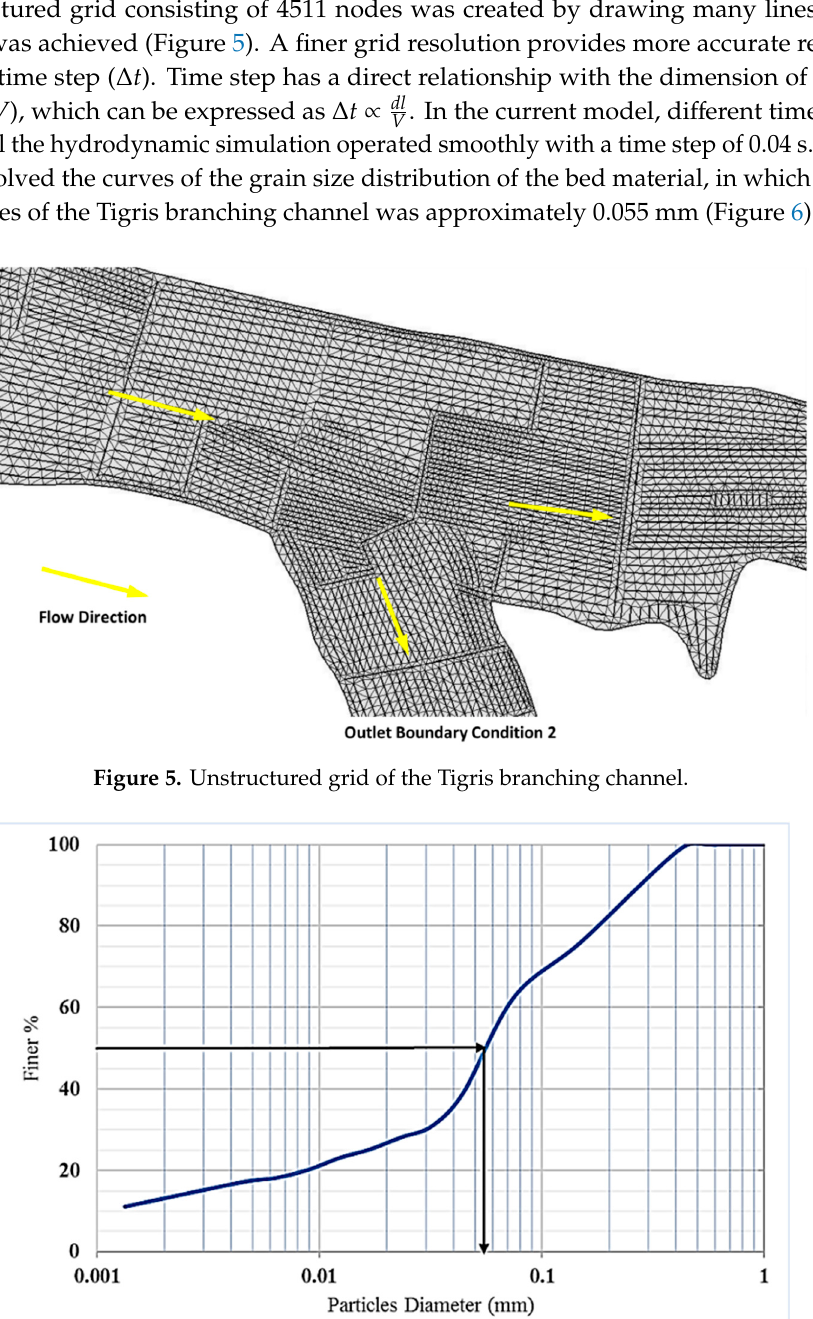
Figure 6. Particles size distribution of the Tigris branching channel, ( d 50 = 0.055 mm).